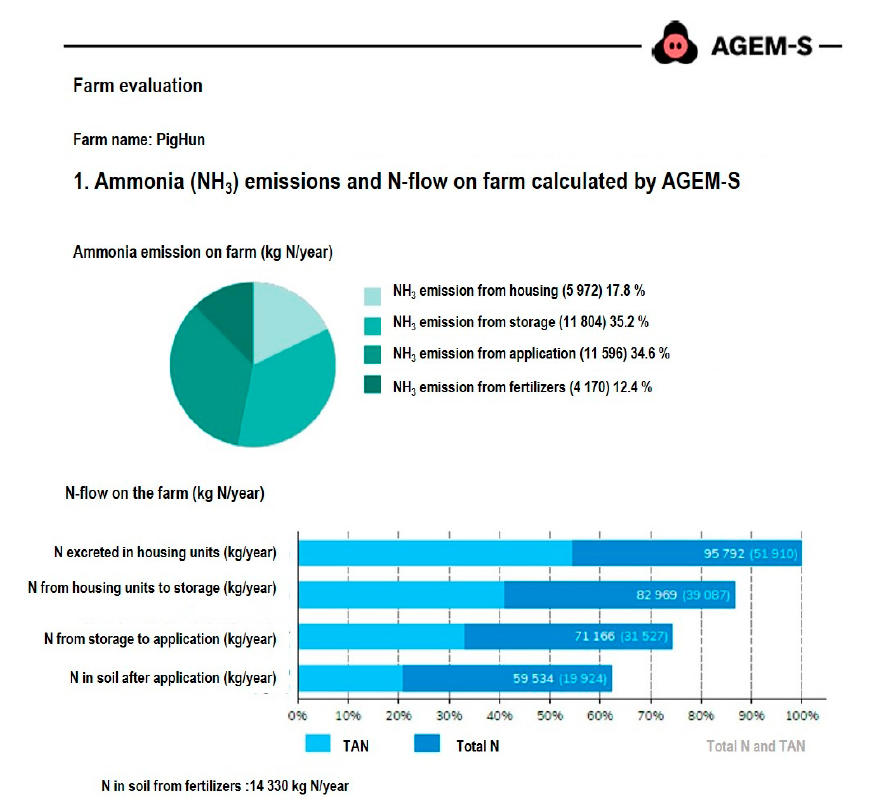
Figure 2. Ammonia emission and N flow on the farm in the AGEM-S (example).